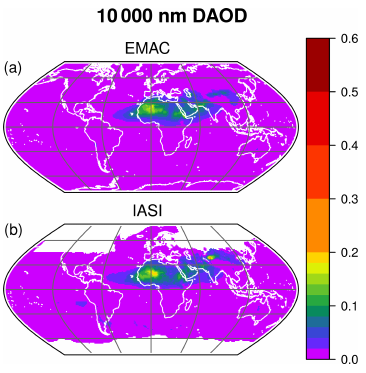
Figure 7. Annual mean for 2011 of the DAOD at 10µm wavelength observed by IASI ( b , IASI ULB dataset version 8) and simulated by EMAC (a) at T106L31